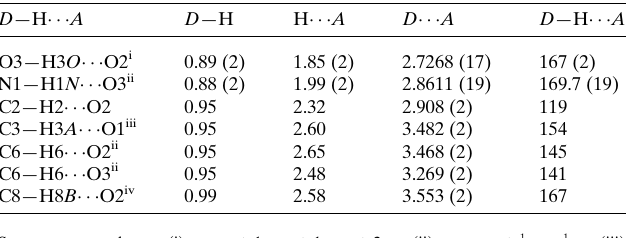
Table 1 Hydrogen-bond geometry (A˚ , (cid:2) ).